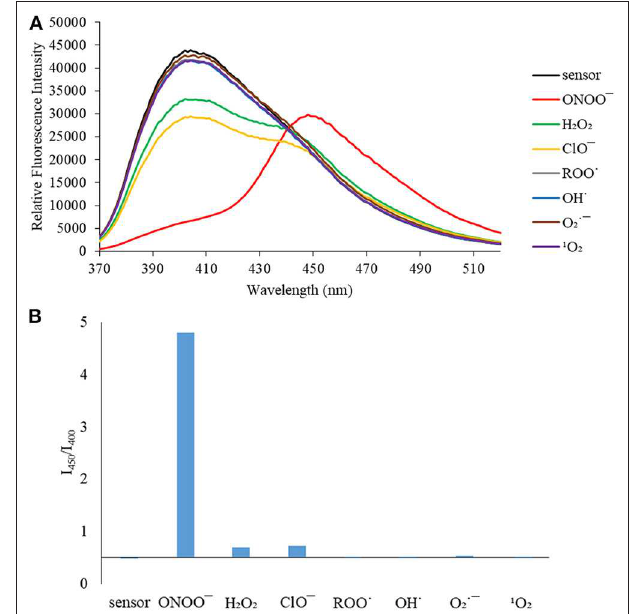
FIGURE 3 | (A) Selectivity data for CL (5 µ M): emission spectrum in the presence of ONOO − (50 µ M), OH · (500 µ M), O ·− 2 (500 µ M), 1 O 2 (500 µ M) after 5min. H 2 O 2 (1mM), ROO · (500 µ M) and ClO − (500 µ M) were measured after 30min. The data was obtained in PBS buffer, pH = 7.4 at 25 ◦ C at λ ex = 340 (bandwith: 20) nm on a BMG Labtech CLARIOstar ® plate reader. (B) Selectivity data for CL (5 µ M): relative intensity ratio in the presence of ONOO − (50 µ M), OH · (500 µ M), O ·− 2 (500 µ M), 1 O 2 (500 µ M) after 5min. H 2 O 2 (1mM), ROO · (500 µ M) and ClO − (500 µ M) were measured after 30min. The data was obtained in PBS buffer, pH = 7.4 at 25 ◦ C at λ ex = 340 (bandwith: 20) nm on a BMG Labtech CLARIOstar ® plate reader.